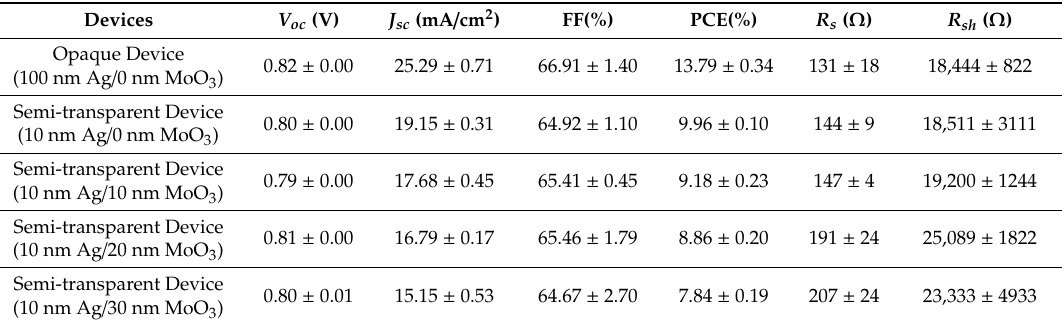
Table 1. Photovoltaic parameters summary including the Open-Circuit Voltage ( V oc ), Short-Circuit Resistance ( R sh ). The parameters were measured at room temperature under one-sun test condition (AM1.5 G illumination, 100 mW / cm 2 ), and the average value and the standard deviation were determined from the measurement of at least five devices.